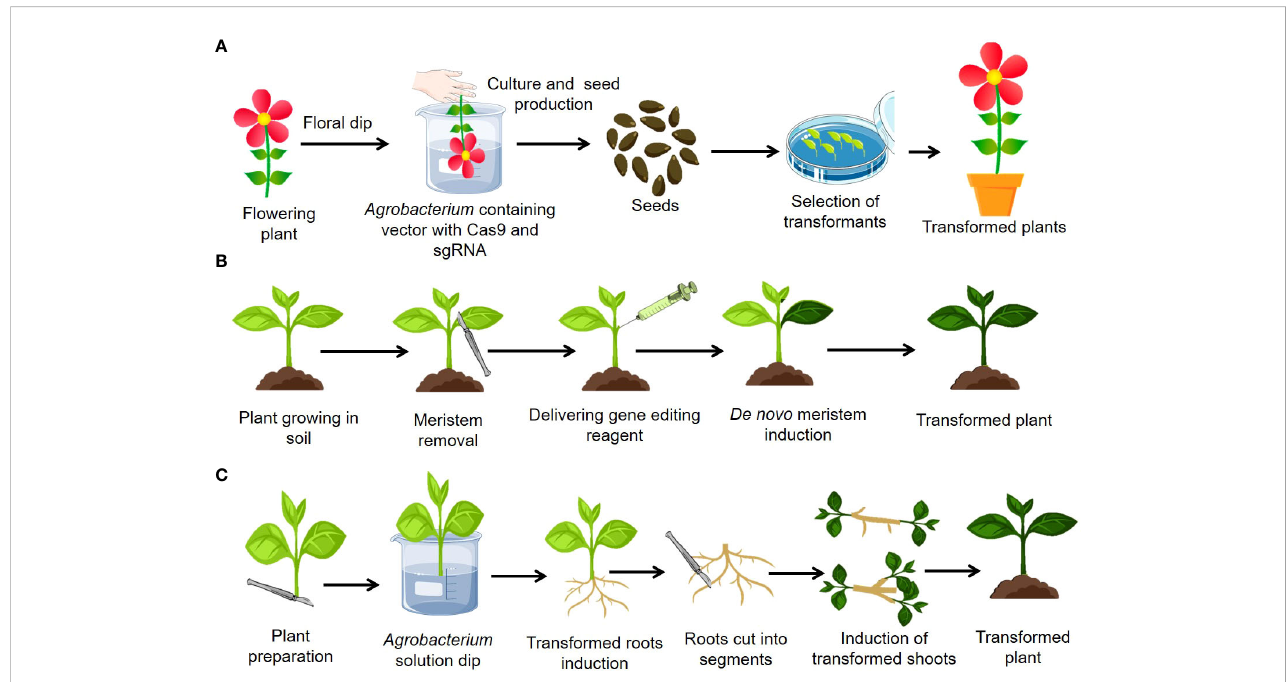
FIGURE 4 Advances in delivery of gene editing reagents in plants bypassing tissue culture (A) In planta transformation (B) De novo meristem induction method (C) Cut Dip Budding